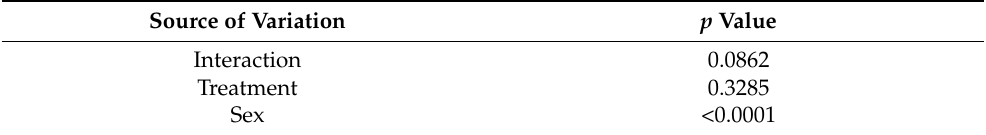
Table 1. Statistical table of the individual effects and interactions of rat sex and treatment on cardiac ROS concentration.